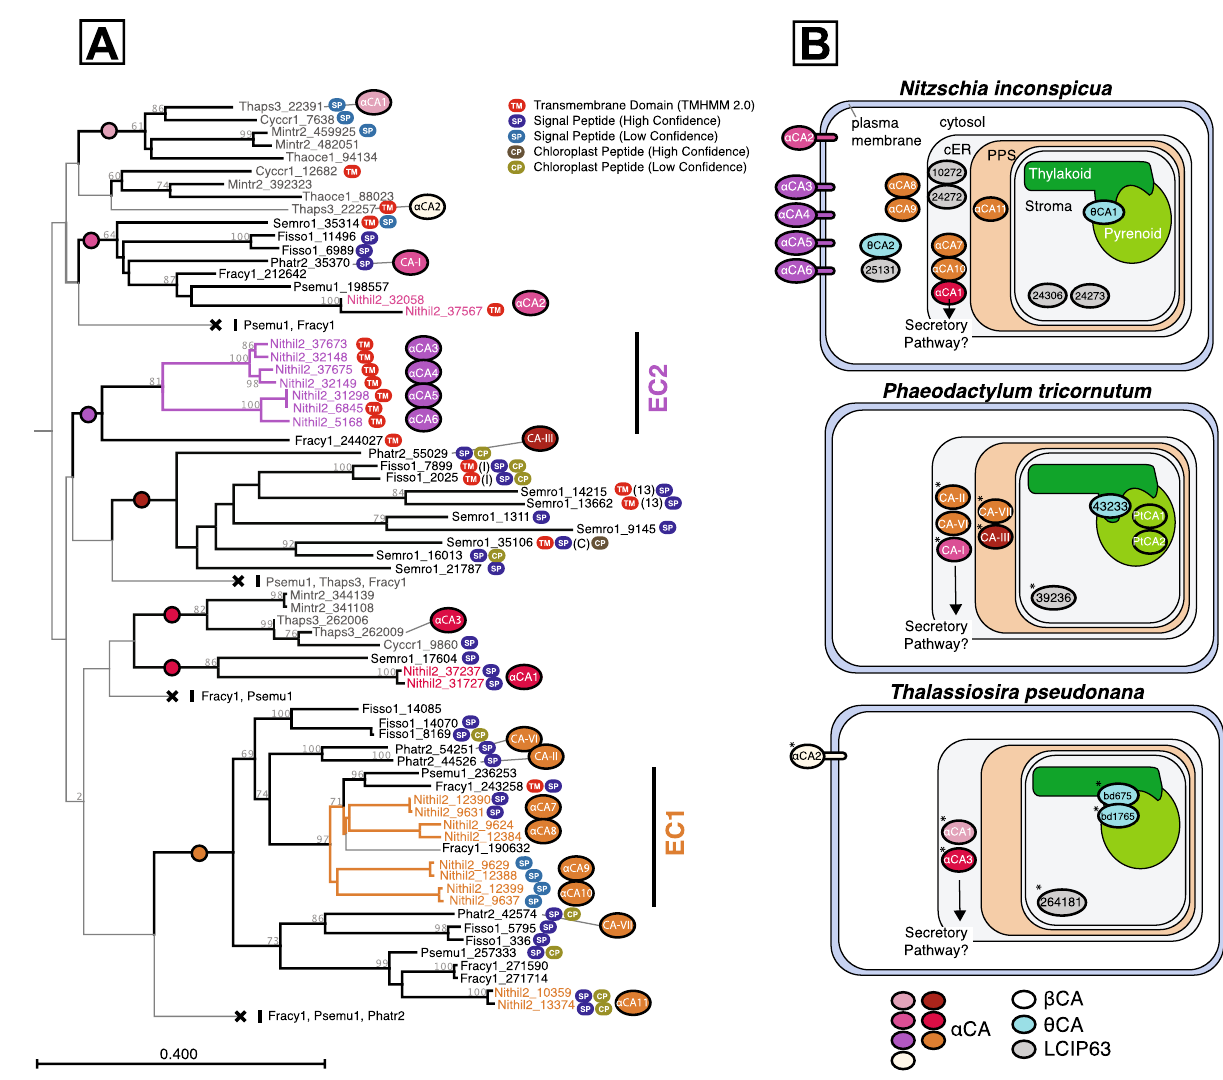
Figure 7. Carbonic anhydrase genes supporting carbon concentration mechanisms. ( A ) Maximum-likelihood phyogeny of putative α-carbonic anhydrases (CAs) from diatom genomes. ( B ) Models of carbon concentrating mechanisms (CCMs) for N. inconspicua compared to P. tricornutum , and T. pseudonana (after 51 ), showing predicted subcellular compartment distributions (cER = chloroplast endoplasmic reticulum, PPS = periplastid space). In ( A ), basal branches with higher bootstrap support (> 30) are thicker and denoted with colored circles corresponding to colors in ( B ). Bootstrap values are shown only for nodes with > 60% support. Sequence identifiers are JGI PhycoCosm accessions 86 , with taxonomic abbreviations as defined in Supplementary Fig. 7. Centric diatom species are colored grey, pennate species black, and N. inconspicua sequences with the basal branch color, to highlight placement within the diatom phylogeny. Both N. inconspicua alleles are shown, when available. Targeting information (Supplementary Dataset 1) is indicated by the following abbreviations: TM, transmembrane domains; SP, signal peptide; CP, chloroplast transit peptide. Asterisks indicate differences from previously proposed CCM models. Chloroplast low confidence predicted genes are assigned to the PPS. Other CA classes (δCA, γCA, ζCA) are not depicted. Protein accession numbers for all species represent entries in the PhycoCosm web portal 86 . Supporting results obtained from SignalP, ASAFind, Mitofates, and TMHMM are provided in Supplementary Dataset